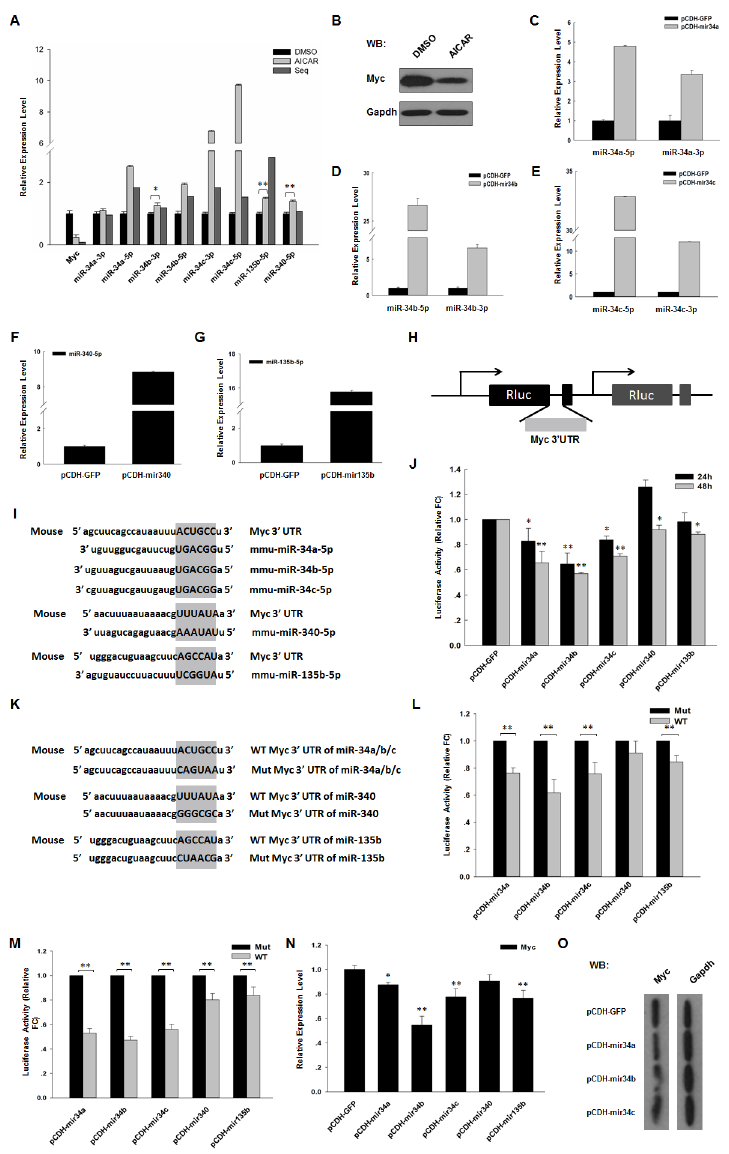
Figure 4. Several miRNAs targeted Myc and down-regulated its expression. (A) The expression of Myc and the predicted miRNAs was validated by real-time PCR in the presence of 1 mM AICAR. (B) Western blot analysis of Myc expression in J1 ES cells in the presence of 1,000 U/ml LIF and with or without 1 mM AICAR for 24 h. Cell lysates were extracted and analyzed by western blot. Relative expression level were comparing to Gapdh. (C/D/E/F/G) MiR-34a/34b/34c/340/135b expression vector pCDH-mir34a/34b/34c/340/135b and their negative control were transfected into J1 ES cells, and miR-34a/34b/34c/340/135b expression was detected by real-time PCR. (H) The schematic representation for construction of the firefly luciferase reporter vector. Myc 3 9 -UTR was inserted into psiCHECK-2 vector by XbaI and EcoRI sites. (I) Brief description of predicted miRNAs and their target sites on Myc 3 9 -UTR. (J) The luciferase reporters were co-transfected with miRNA expression vectors, and empty vector pCDH-GFP without insertion was used as control. 24 and 48 h after transfection, luciferase activity was detected using dual-luciferase reporter assay. (K) Brief description of mutated sites on Myc 3 9 -UTR. (L) The mutated luciferase reporters were co-transfected with miRNA expression vectors, and empty vector pCDH- GFP without insertion was used as control. 24 h after transfection, luciferase activity was detected using dual-luciferase reporter assay. (M) The mutated luciferase reporters were co-transfected with miRNA expression vectors, and empty vector pCDH-GFP without insertion was used as control. 48 h after transfection, luciferase activity was detected using dual-luciferase reporter assay. (N) The indicated miRNA expression vectors were transfected into J1 ES cells. 48 h after transfection, Myc expression was detected by real-time PCR. Gapdh was used to normalize template levels. (O) The indicated miRNA expression vectors were transfected into J1 ES cells. 48 h after transfection, cell lysates were extracted and analyzed by western blot. Relative expression level were comparing to Gapdh. (WB: western blot; *: p , 0.05; **: p , 0.01).